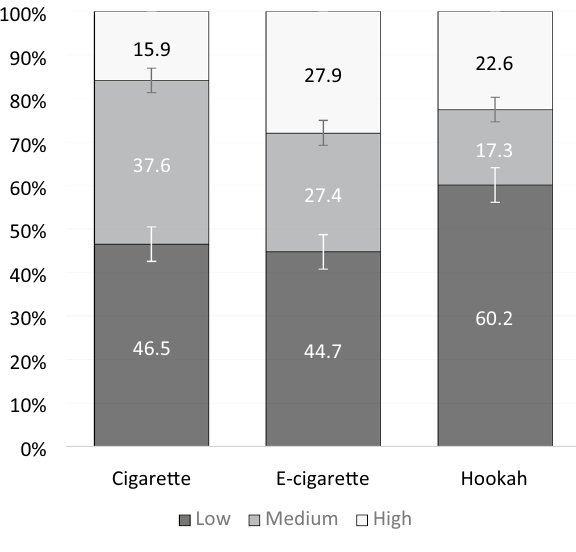
Figure 1. Expanded Susceptibility to Smoking Index (ESSI) for non-smoking students. N = 226; Standard error